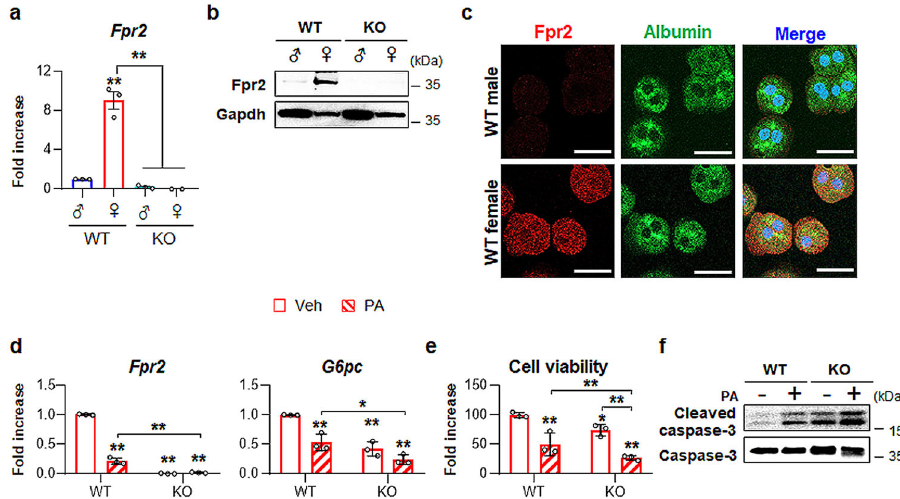
Fig. 7 Higher expression of Fpr2 in the livers of female mice is related with hepatocyte protection. a qRT-PCP analysis for Fpr2 expression in primary hepatocytes (pHEPs) from WT (male n = 2, female n = 2) and KO mice (male n = 2, female n = 2). Total eight mice were employed in each hepatocyte isolation, and the experiments were replicated at least three times and the mean ± S.E.M. results are graphed (* p < 0.05, ** p < 0.005 vs WT male-pHEPs). b Western blot analysis and c double immuno fl uorescent images of Fpr2 (red) with albumin (green) in these cells. Gapdh was used as internal control. DAPI (blue) was used as nuclear counterstaining. Data shown represent one of three experiments with similar results (Scale bar, 20 μ m). d qRT-PCR analysis for Fpr2 and glucose-6-phosphatase ( G6pc) in, e cell viability of, and f western blot analysis of cleaved Caspase-3 and pro Caspase-3 in WT and KO female mice-isolated pHEPs treated with vehicle (Veh) or 250 μ M of palmitate (PA). The data shown represent one of three experiments with similar results. The mean ± S.E.M. results obtained from three repetitive experiments are graphed (* p < 0.05, ** p < 0.005 vs WT-Veh). Gray circles represent individual data points. See Supplementary Data for statistical